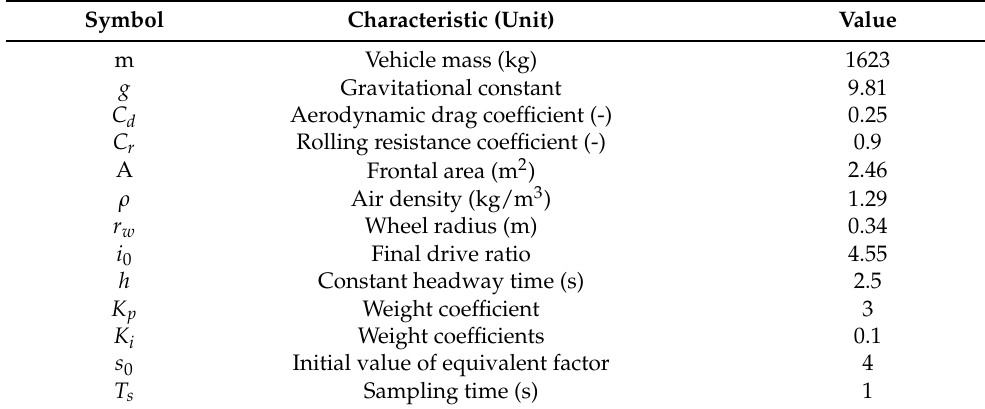
Table 2. Parameter settings in the simulation.